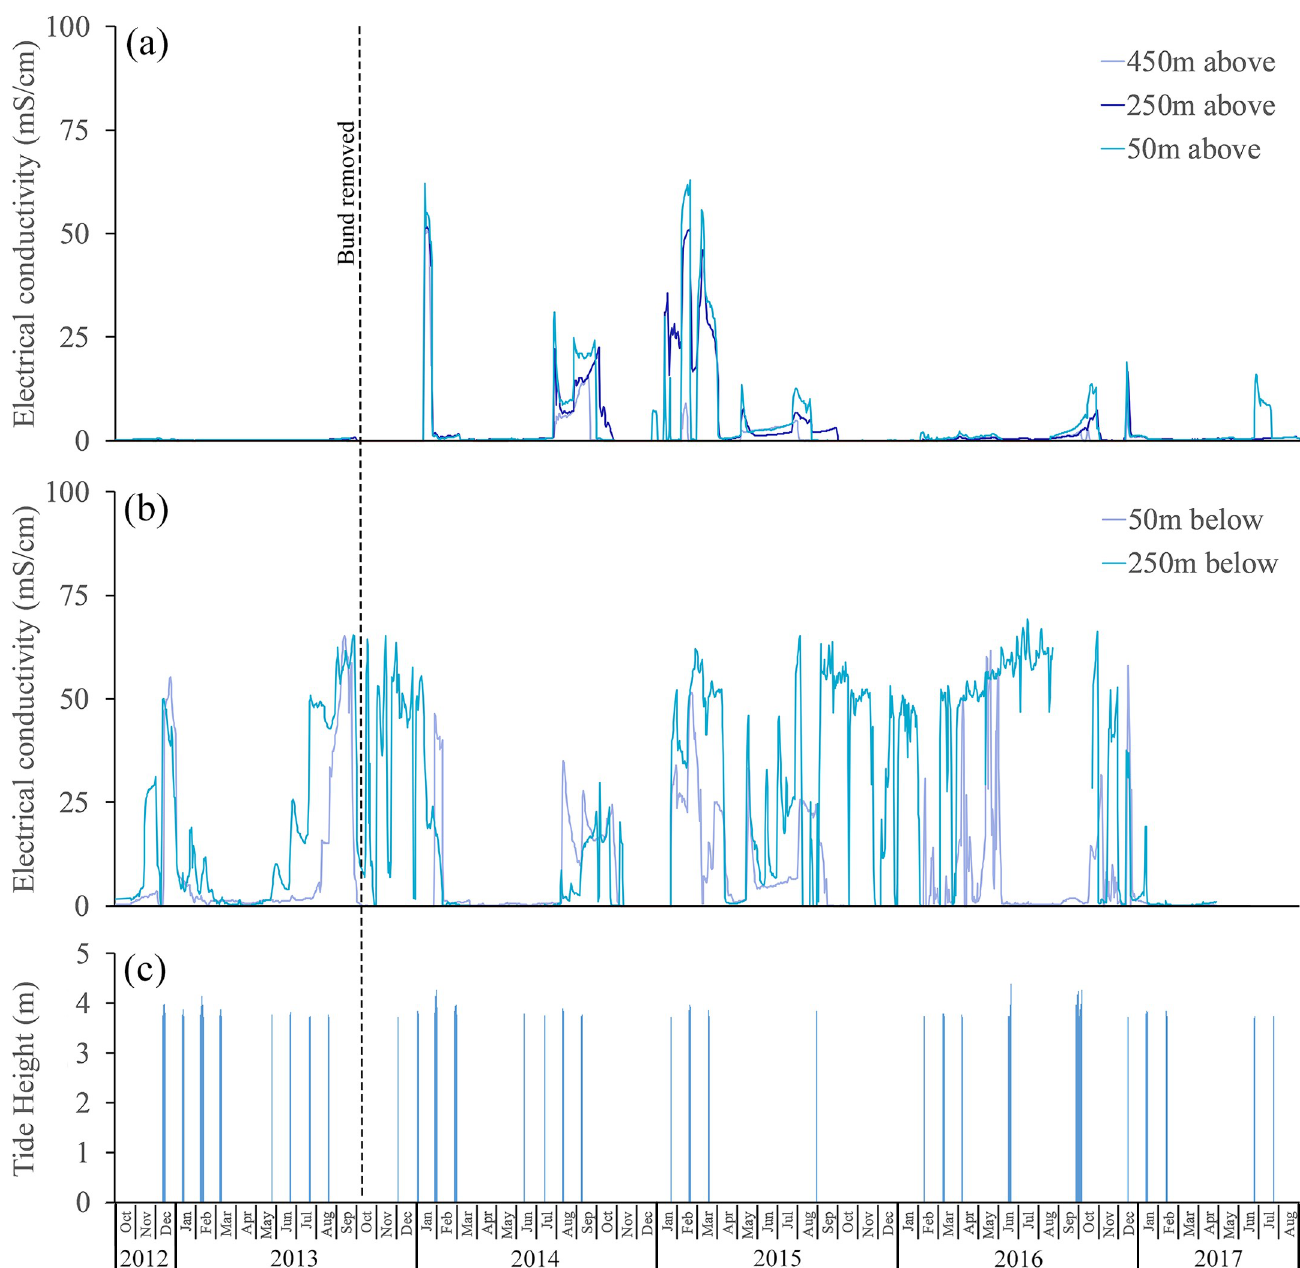
Fig 4. Changes in salinity above and below the bund location and tides > = 3.6 m—October 2012 to August 2017. Logger distances above the bund are 450 m, 250 m and 50 m and below are 50 m and 250 m. The bund was removed on the 6th October 2013. High tides ( > = 3.6 m) are for Forrest